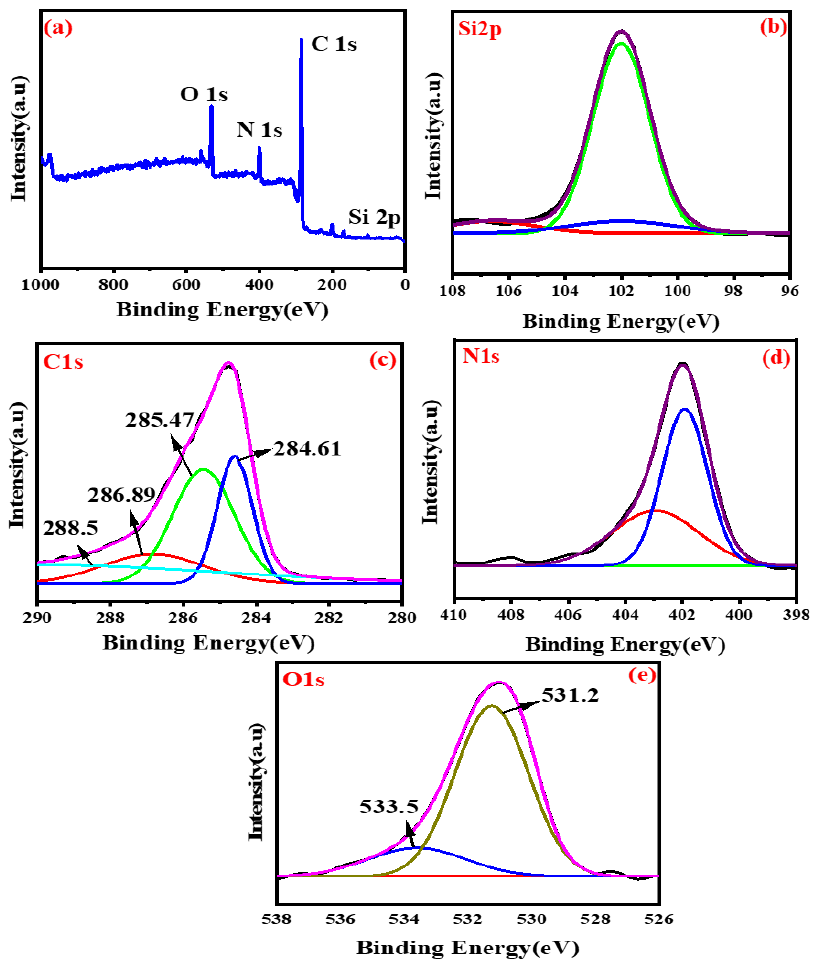
Figure 2. ( a ) Full XPS spectrum of PANI-GO-APTES. ( b ) Deconvoluted peak of Si. ( c ) Deconvoluted peak of carbon. ( d ) Deconvoluted peak of nitrogen. ( e ) Deconvoluted peak of oxygen. Carbon is deconvoluted into four peaks, namely C-O-C/C-O-Si, C-C/C=C, C-N and C=O corresponding to 286.89, 284.6, 285.47 and 288.5 eV, respectively [41], as presented in Figure 2c.